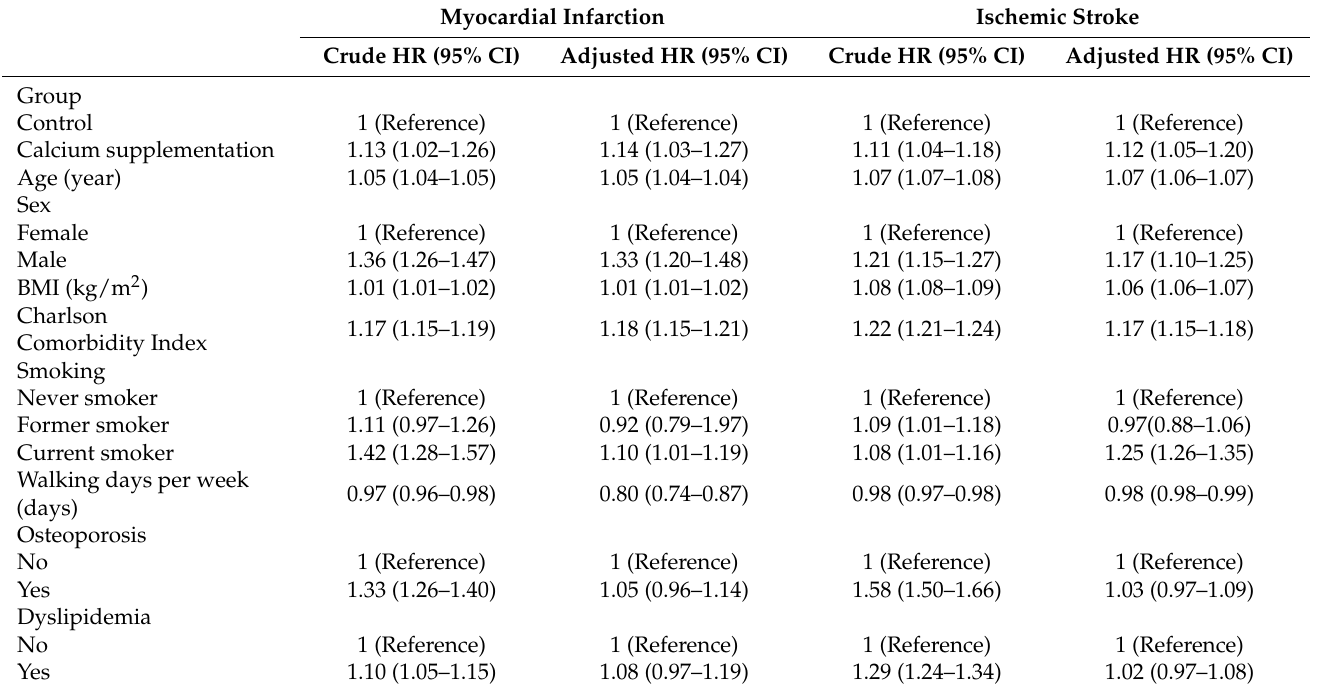
Table 3. Cox proportional hazards model for cardiovascular events. Myocardial